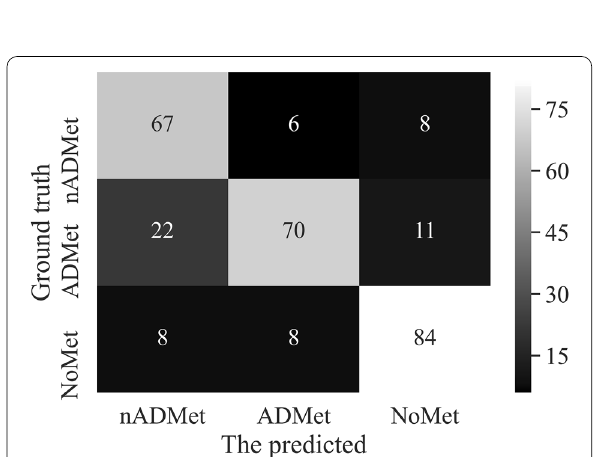
Table 4 Scores of evaluation metrics obtained by Classifer- inRAC and Classifer-outRAC on testing samples in dataset D3 Best value in each column is highlighted in bold